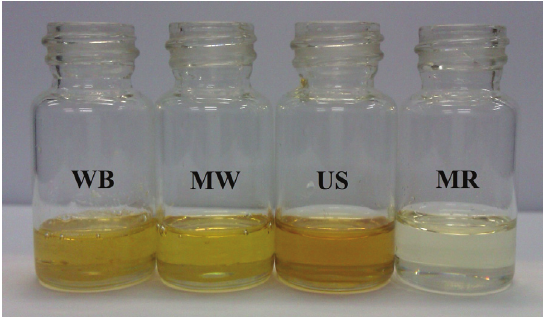
mmim][Br] syntheses obtained by various Figure 7 Products of [C 7 processes after reaching equilibrium product concentration. Pro- cesses were performed and denominated as stated in Figures 3 and 6,